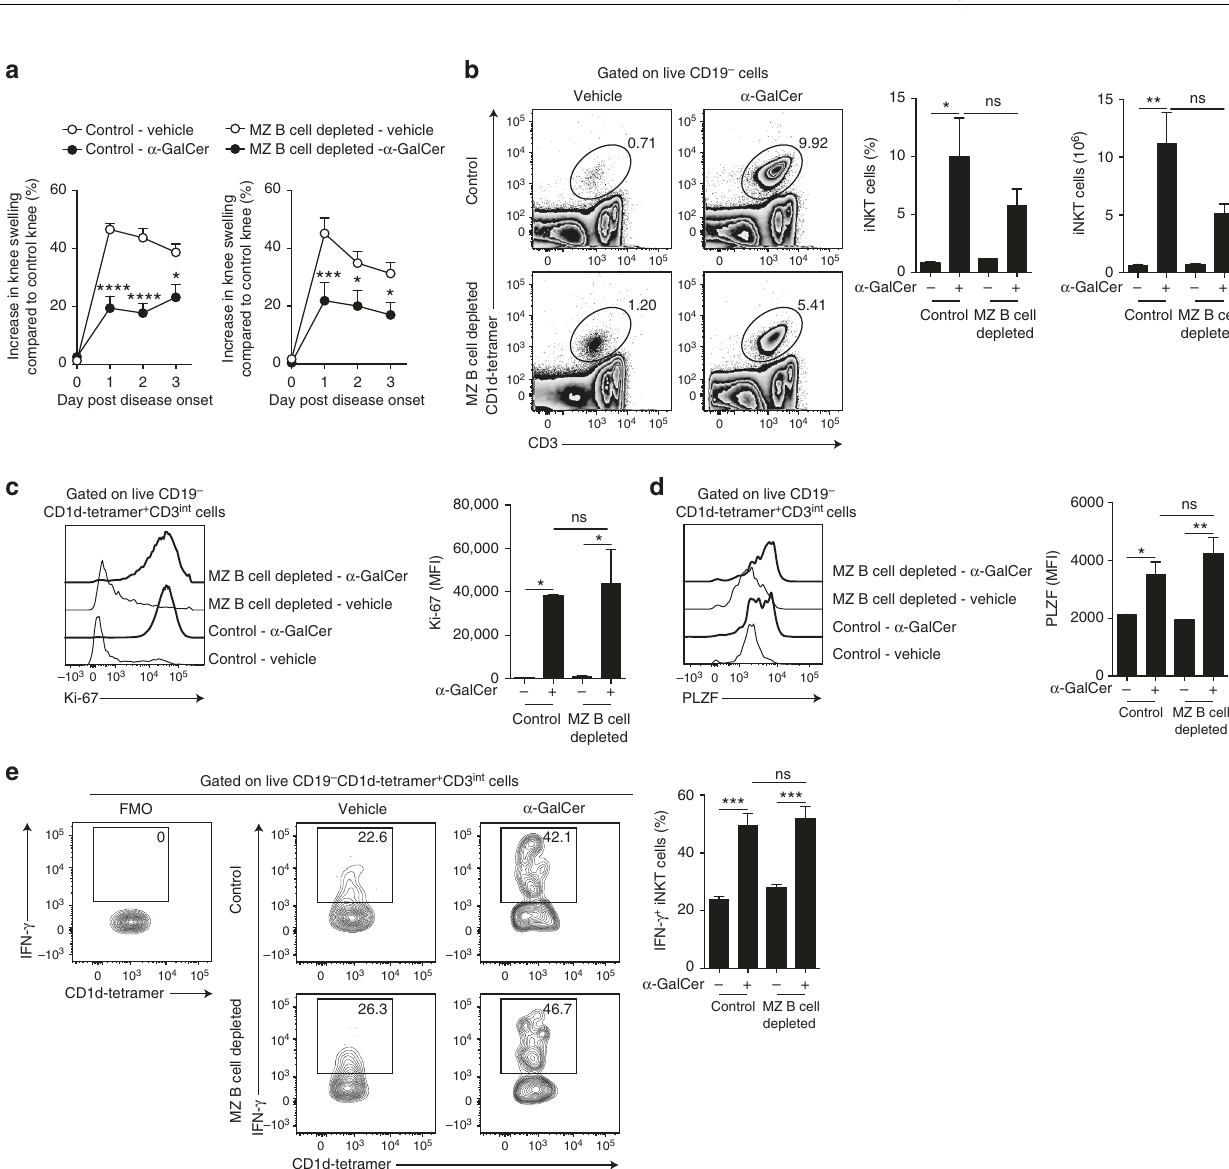
Cell preparation . Spleens and livers were collected in complete RPMI-1640 with L - glutamine and NaHCO 3 (cRPMI, Sigma-Aldrich) with 1:10 FBS (Biosera), 1:100 penicillin (10,000 units/ml)/streptomycin (10 mg/ml) (Sigma-Aldrich), and 1:1000 50 mM 2-mercaptoethanol (Gibco, Invitrogen). Single-cell suspensions were obtained by dissociating the tissue through 70- μ M cell strainers (BD Biosciences), and erythrocytes in spleens were lysed using red blood cell (RBC) lysis buffer (Sigma-Aldrich). For the isolation of liver mononuclear cells, Percoll (Amersham Biosciences) 30%/70% gradient was used with subsequent RBC lysis. Generation of mixed bone marrow chimeric mice . Mixed BM chimeric mice were generated. Brie fl y, recipient WT mice received 8Gy of γ -irradiation via a